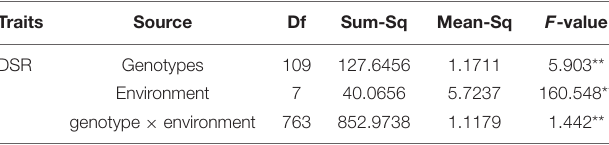
TABLE 2 | ANOVA for DSR traits across multiple environments. Traits